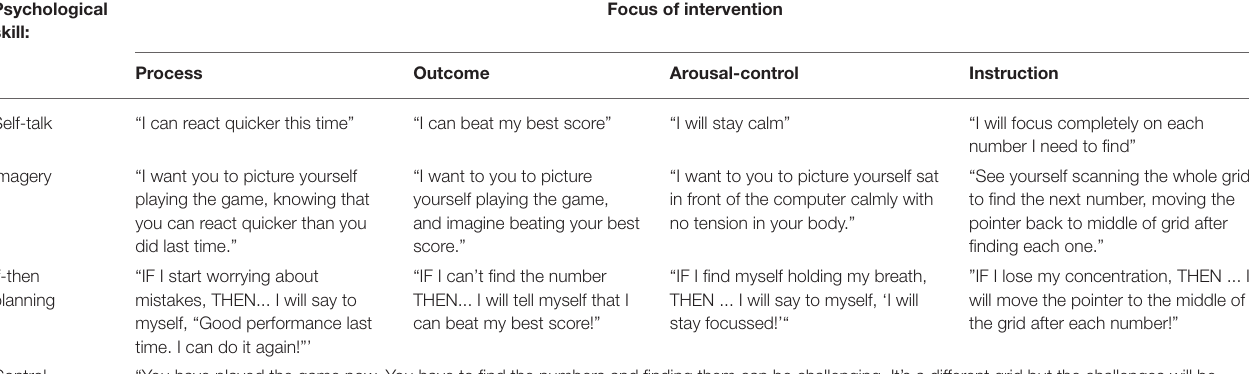
Focus of intervention